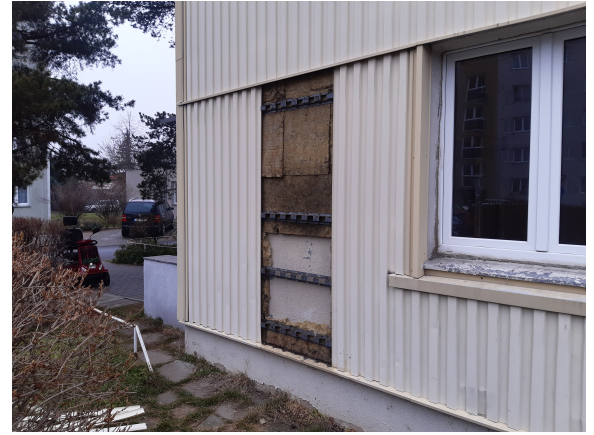
Figure 1. Building facade under reconstruction.